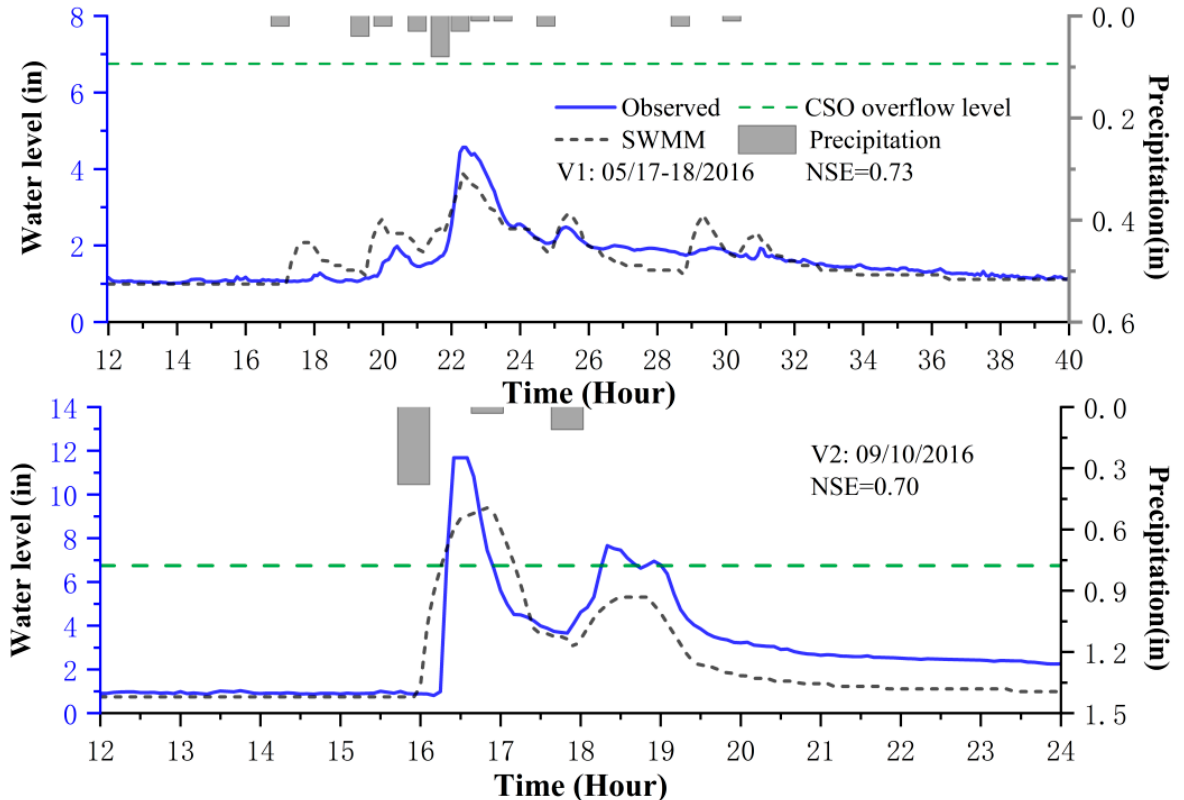
Figure A1. Model calibration.